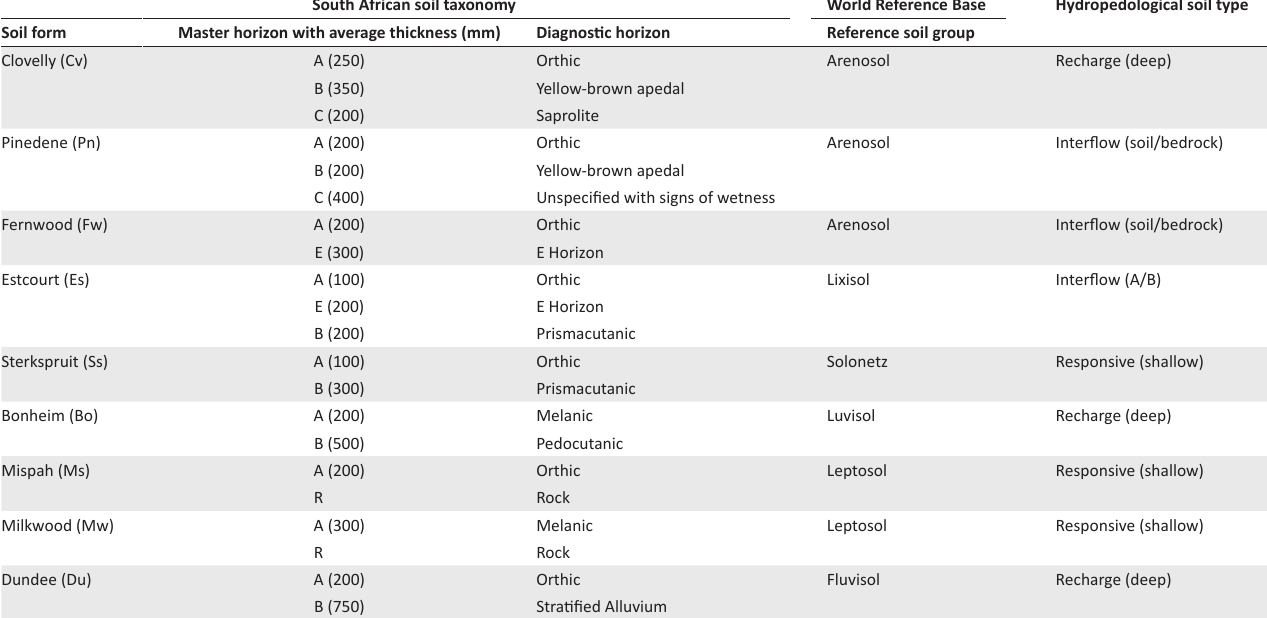
TABLE 1: Soil forms, diagnostic horizons, world reference base groups and hydropedological response types on the